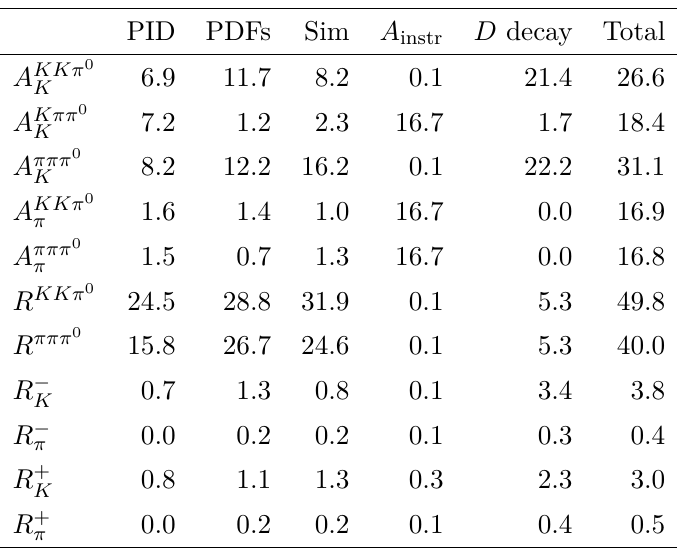
Table 2 . Systematic uncertainties on the observables, multiplied by 10 4 . PID refers to the fixed PID efficiencies of the companion tracks. PDFs refers to the uncertainties in fixing parameters in the fit PDF. Sim refers to the use of simulation to calculate relative efficiencies between the B − → DK − and B − → Dπ − modes. A instr refers to the interaction and detection asymmetries. D decay refers to the effect of assuming that the distribution of candidates in the D meson decay phase-space is not sculpted by the selection. The Total column corresponds to the quadrature sum over the five